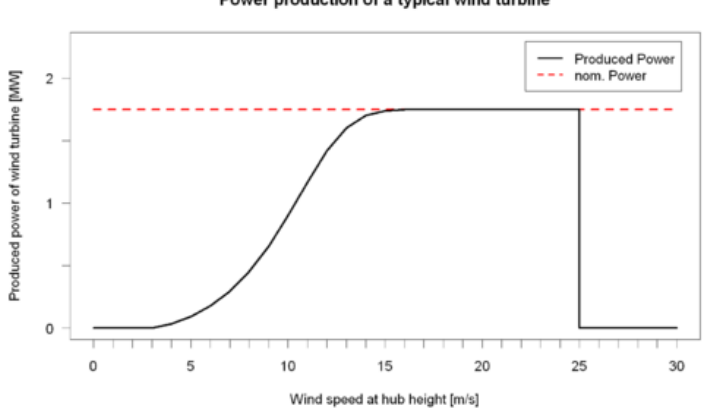
Figure 2. Power curve for wind speed and power production.